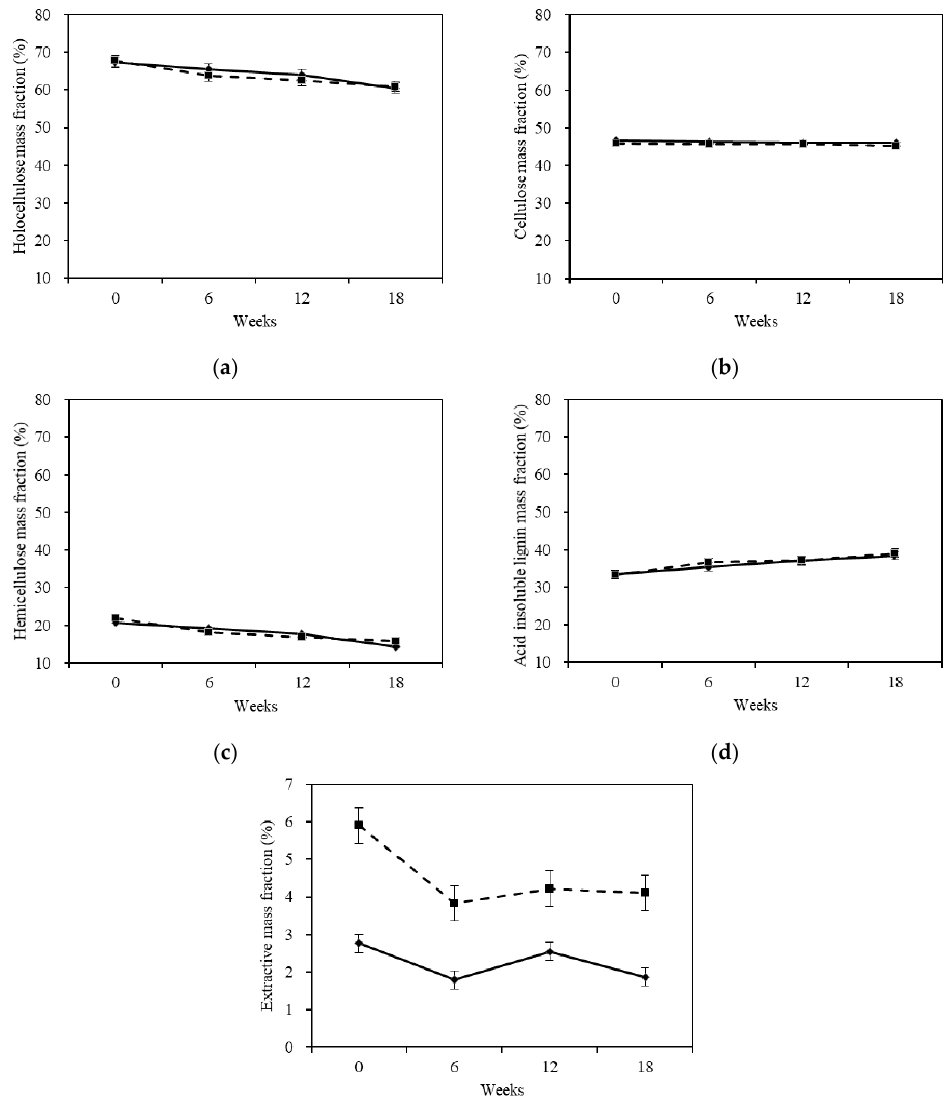
Figure 4. Changes of chemical compositions mass fraction after degradation. ( a ) Changes of holocellulose mass fraction; ( b ) Changes of cellulose mass fraction; ( c ) Changes of hemicellulose mass fraction; ( d ) Changes of acid-insoluble lignin mass fraction; ( e ) Changes of extractives mass fraction. The continuous and discontinuous lines in the figure caption indicates sapwood and heartwood. The error bar is according to a confidence interval of 95%.